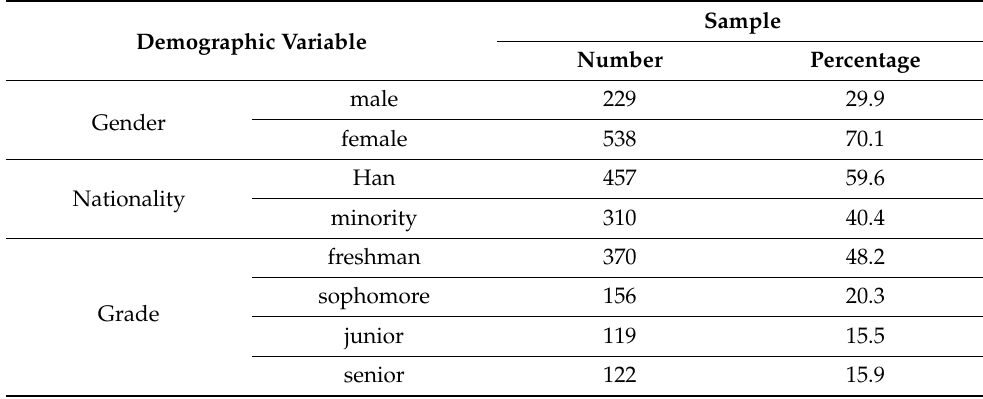
Table 1. Demographic information of the